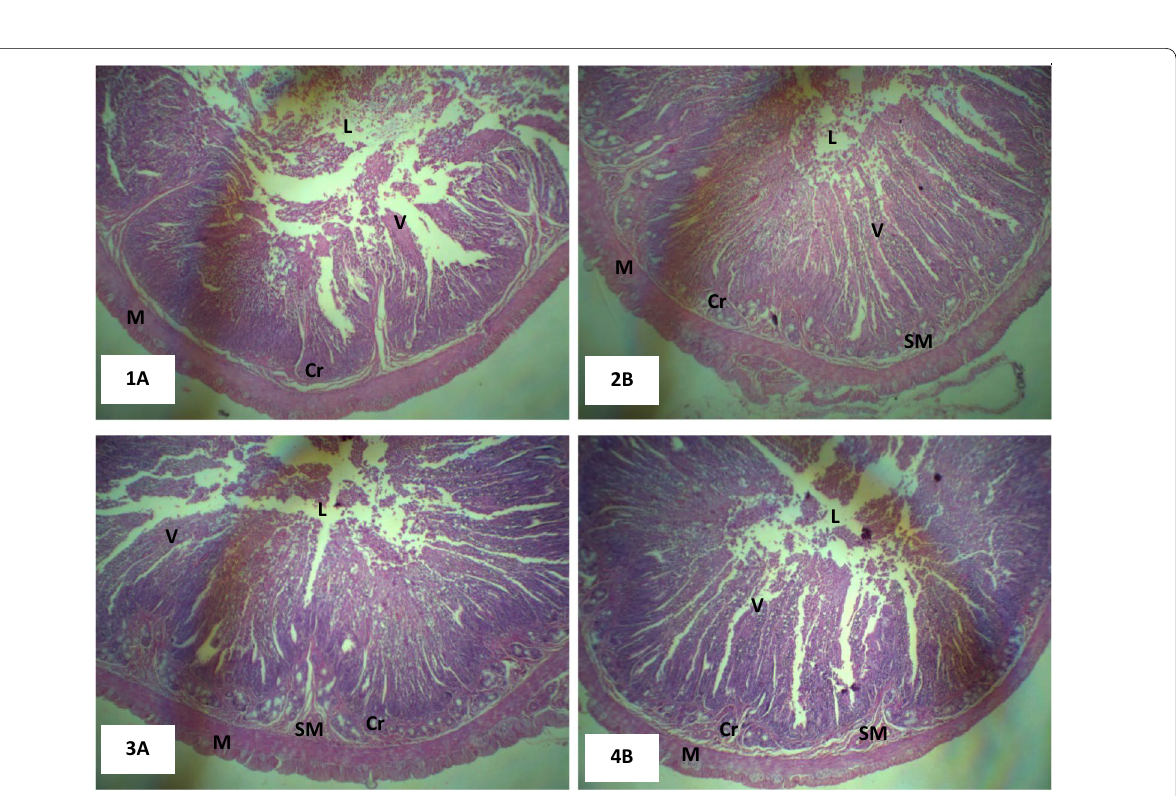
100). 1a Control; 2b 0.1% S. cerevisiae ; 3a 0.1% B. subtilis ; 4b 0.05% S. ×